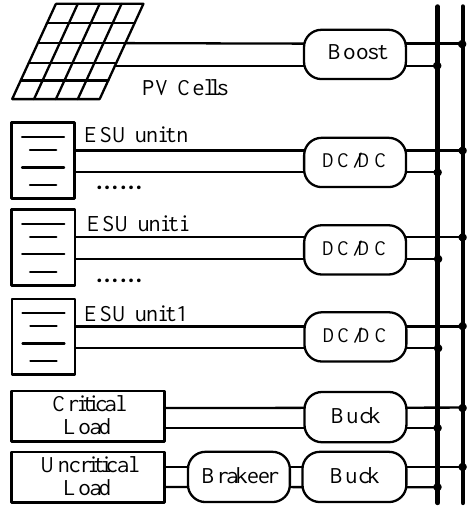
Figure 1. DC microgrid structure under investigation.